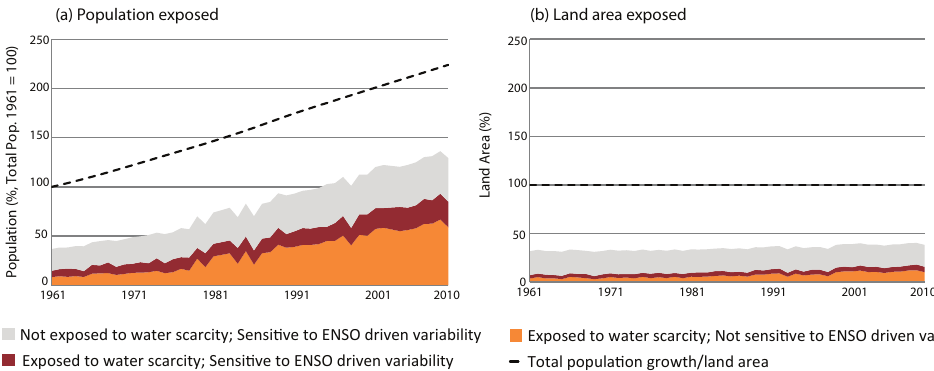
Figure 4. Development of population and land area exposed to water scarcity events and/or being sensitive to ENSO-driven climate variability over the period 1961–2010, as estimated with the CTA ratio. (a) shows the growth in population living under water scarce conditions and/or living in areas sensitive to ENSO-driven climate variability relative to the total growth in global population (set at 100 in 1961). (b) shows the increase in land area exposed to either water scarcity events and/or ENSO-driven climate variability relative to the total global land area